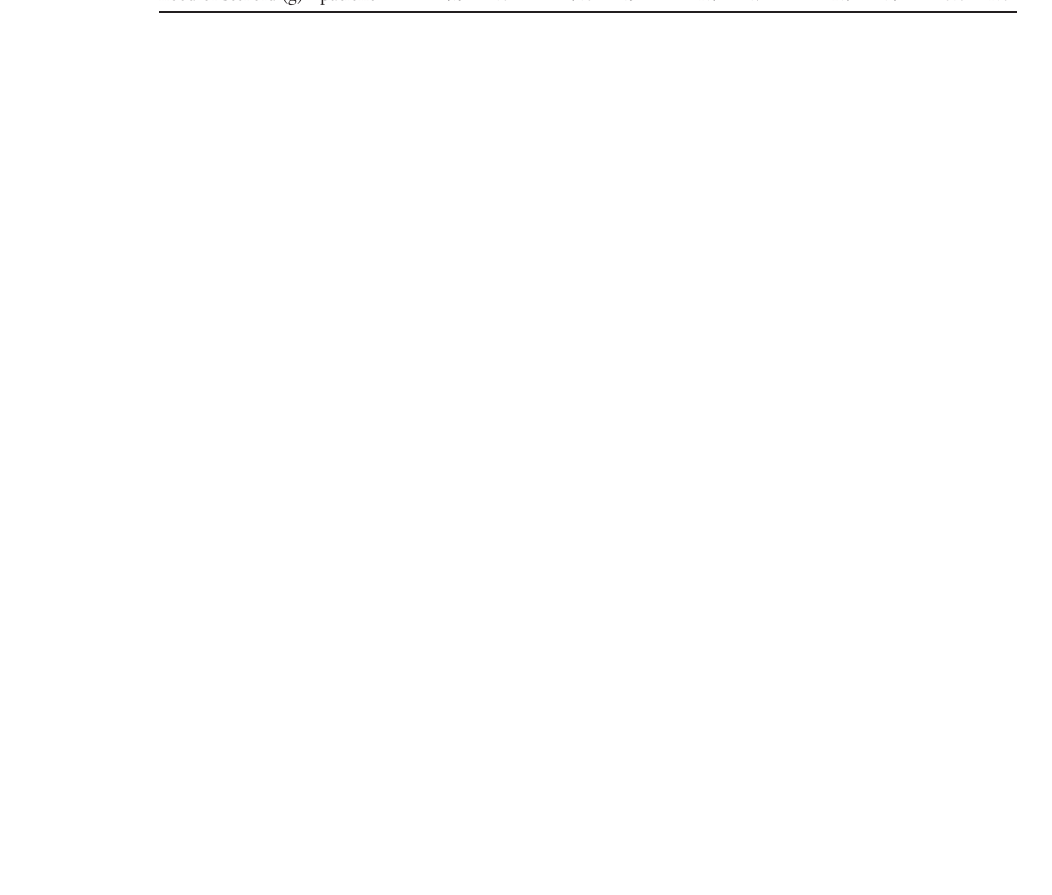
Differences observed during the 3 years of IFN b -1b treatment (mean ±